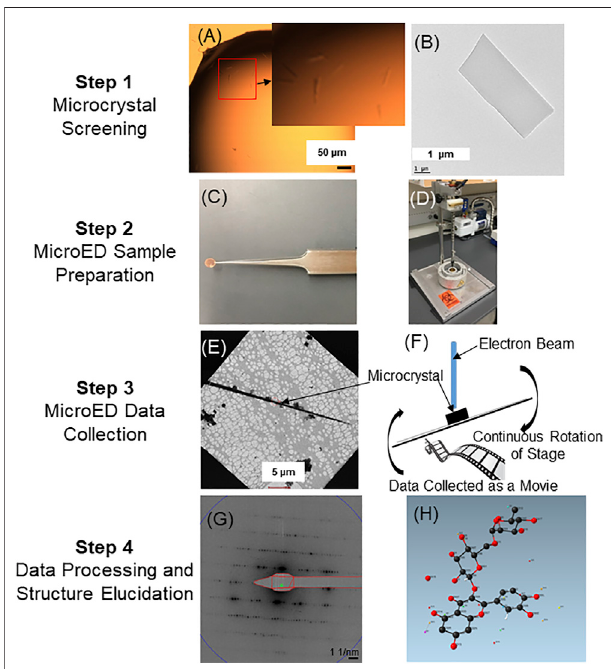
FIGURE 2 | MicroED small molecule structure elucidation work fl ow. Following puri fi cation, samples are initially screened for the presence of microcrystals using either a light microscope or TEM. Panel (A) illustrates representative needle-shaped crystals in solution as observed under a light microscope (see zoomed inset of A). Panel (B) shows a representative single crystal as observed under a TEM. Once microcrystals are detected, samples(powderorinsolution)areappliedontocryo-TEMgrids (C) .Thegrids can then be plunge frozen by rapidly submerging into liquid ethane (D) . Plunge-frozen grids are then analyzed in the cryo-TEM to detect the presence of well-diffracting single crystals. Panel (E) shows the presence of a long needle-shaped microcrystal under low magni fi cation. MicroED data is then collected as a movie from single crystals by continuously rotating the stage as the crystal is exposed in the electron beam (F) . Each frame from the continuous rotation diffraction is extracted (G) for indexing, integration and scaling by using XDSGUI (Kabsch, 2010). Phase information is then determined by SHELXT (Sheldrick, 2008) followed by re fi nement using the SHELXLE (Hübschle et al., 2011). Panel (H) shows the structure of the fl avonoid rutin as determined by MicroED (structure determined from powdered rutin standard purchased from a chemical